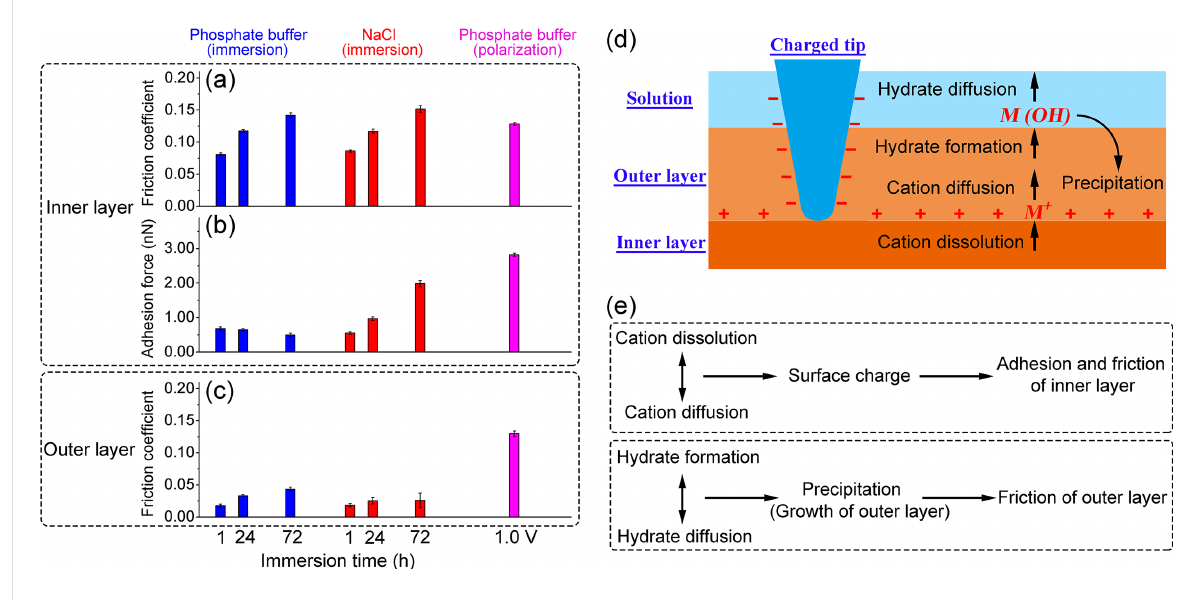
Figure 5: The dependence on immersion time of: (a) friction coefficient of the inner layer; (b) adhesion force of the inner layer; (c) friction coefficient of the outer layer. Data are obtained from linear fits in Figure 4 and error bars represent the errors in the fits. Data for corroded surfaces after polariza- tion in phosphate buffer for 80 min at 1.0 V vs Ag/AgCl are shown for comparison. (d) Schematic illustration of physicochemical processes at the inter- faces of the surface oxide film related to the surface dissolution during corrosion. M + represents dissolved metal cations, M(OH) denotes hydrates formed by reactions of metal cations with the solution. (e) Summary of the influence of corrosion on friction and adhesion of the inner layer and fric- tion of the outer